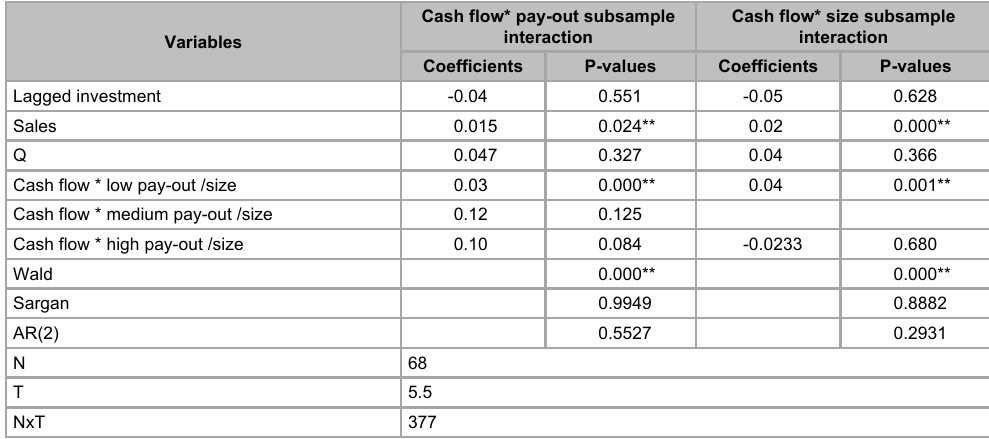
Cash flow interaction with subsamples of pay-out and firm